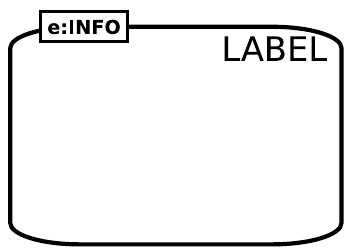
Figure 2.19: The Process Description glyph for compartment .